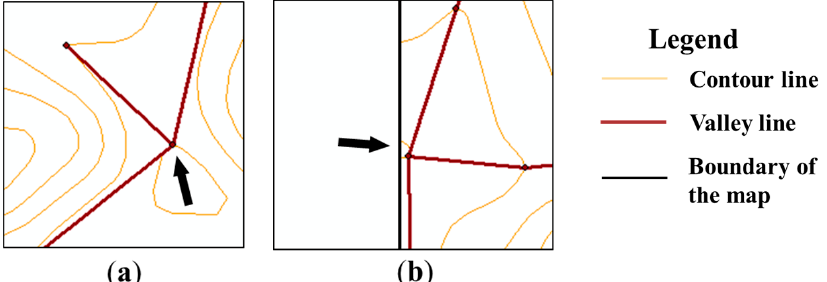
Figure 8. Examples of two types of bottom points: ( a ) bottom point on a closed contour line; ( b ) bottom point on an open contour line. 6. Trimming redundant valley lines. Redundant valley lines occur when individual val- ley points have large deviation while edges generated by valley points in the Delau- nay triangular network in Step (5) are being selected, leading to selection of a short line connecting a valley point on an adjacent contour line. When connecting this val- ley line, the current valley point would be crossed. This point was then used as a seed